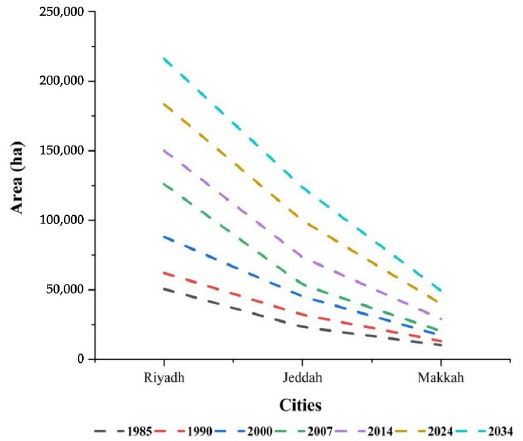
Figure 1. Urban growth pattern over Riyadh, Jeddah and Makkah from 1985 to 2034 (expected) (Alqurashi et al. 2016).